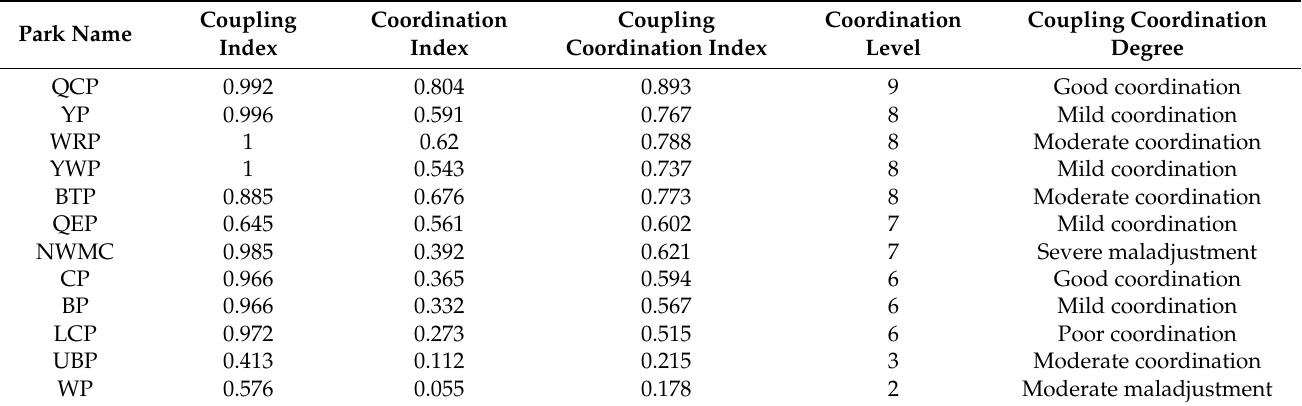
Table 10. Spatial–psychological dimension coupling coordination degree.